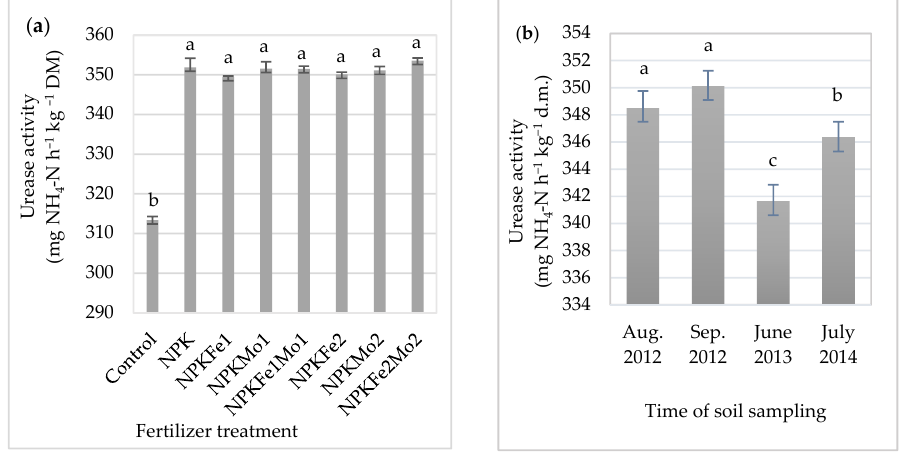
Figure 2. The effects of mineral fertilizer treatment ( a ) and time of soil sampling ( b ) on urease activity. Each bar represents the mean ± SE. The same letters mark no significantly different values ( p ≤ 0.05).